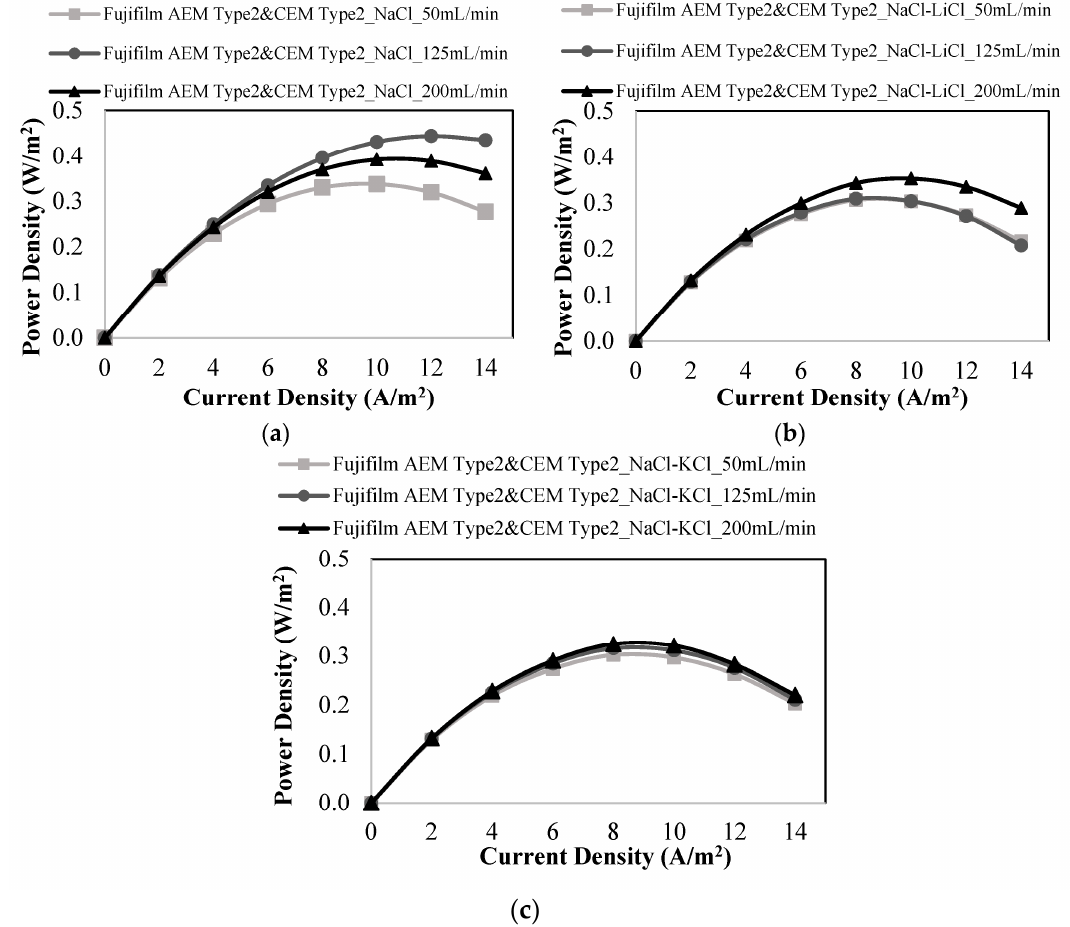
Figure 8. Power density vs. current density plots at different feed flow rates for the studies performed with ( a ) only NaCl, ( b ) a mixture of NaCl and LiCl, ( c ) a mixture of NaCl and KCl using Fujifilm AEM Type 2 & CEM Type 2 membranes.